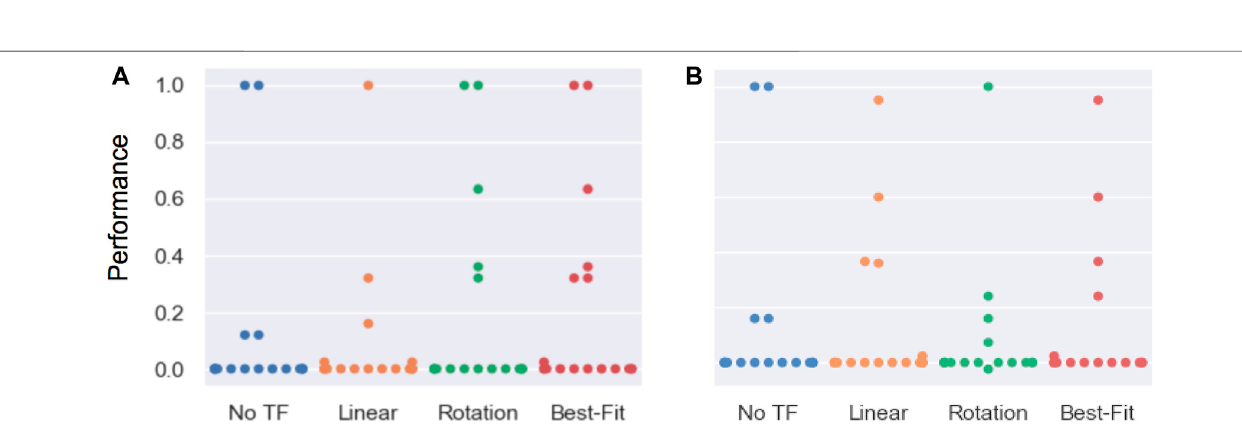
FIGURE14| Resultsforacross-tasktransferusingthescrub-brush (A) andmug (B) asthereplacementtool.Performancewasmeasuredaccordingtothemetrics in Section 5.10 ,scaled between 0 – 1. Theseresults representthe generalizability ofatransform model learned onone task and then applied toadifferenttask using the same tool. Each point represents the performance of a single transfer